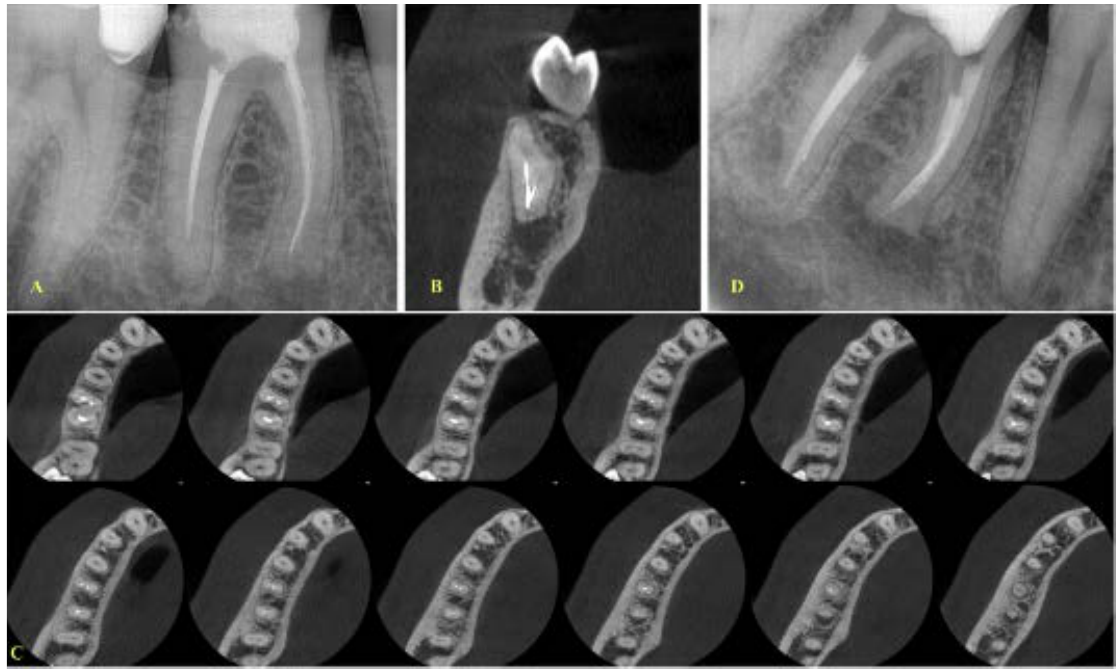
Figure 3. ( A ) Initial periapical radiograph of a mandibular first molar with periapical lesions and a fragment at the apical third of the mesial root (mesiobuccal canal), ( B , C ) . Coronal and axial views demonstrating that the two canals are merging at the apical third ( D ) Final radiograph with the fragment in place. No attempt was made to remove the fragment. Apical patency was achieved through the mesiolingual canal.